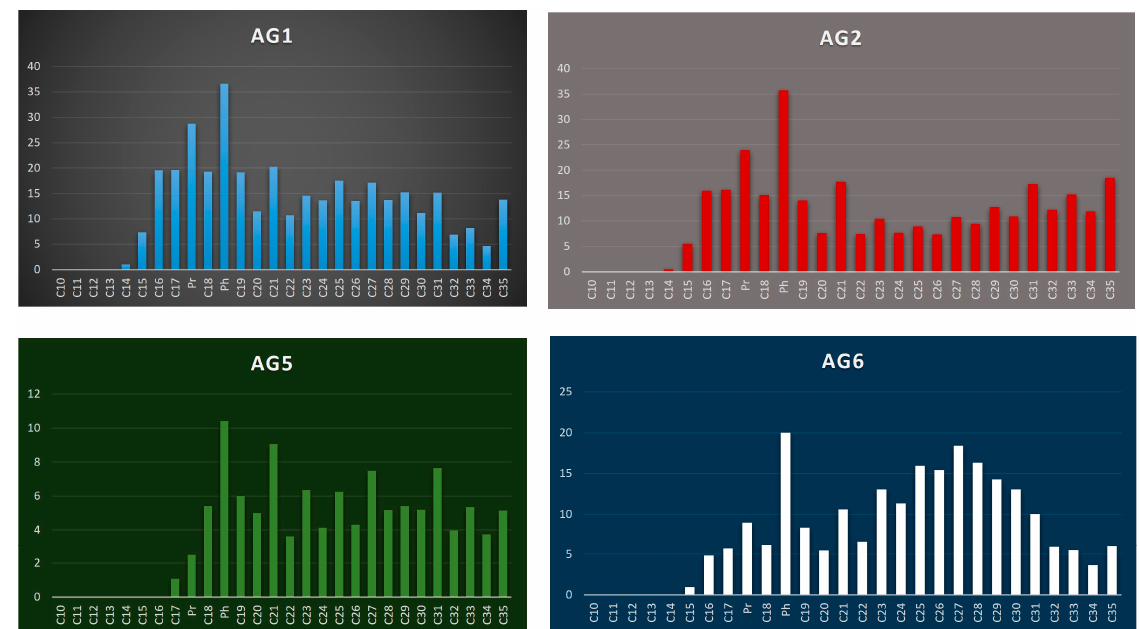
Figure 10. n-alkane distribution of the four samples (AG1, AG2, AG5, and AG6). According to the diagrams of the distributions of n-alkanes, the predominance of light hydrocarbons is observed mainly in the samples AG1 and AG2, (high concentrations of C16-C21), while heaviest hydrocarbons appear in the samples AG5 and AG6 (C25-C35).